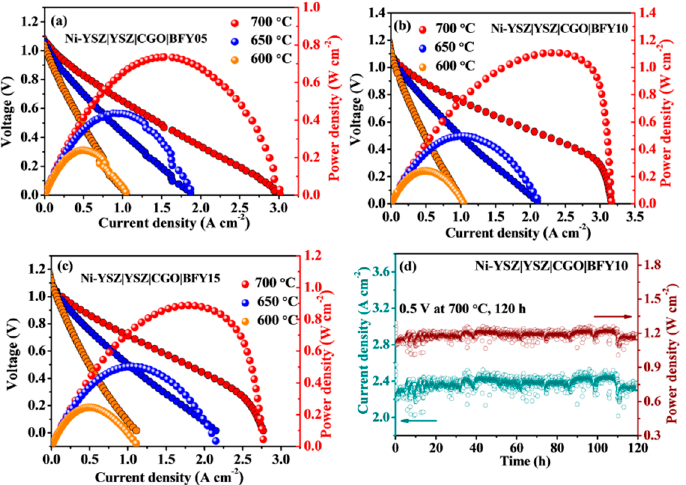
Figure 7. ( a – c ) I – V and I – P curves of the single cells with BFY x cathodes at 600–700 °C; ( d ) Stability test of the single cell with BFY10 cathode under an output voltage of 0.5 V.